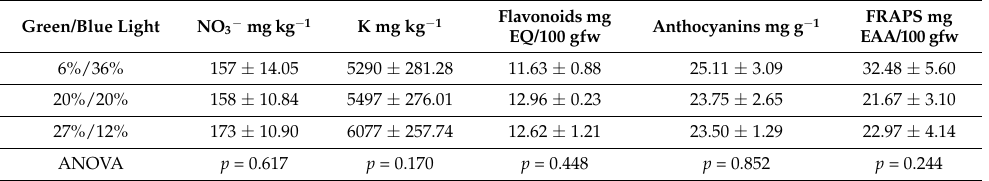
Table 7. Effect of the green (500–600 nm) and blue (400–500 nm) light balance on selected ions concentration and on flavonoids, anthocyanins and antioxidant activity measured by FRAPS from extracts of strawberry fruits of plants grown in an indoor vertical system with LED lighting.